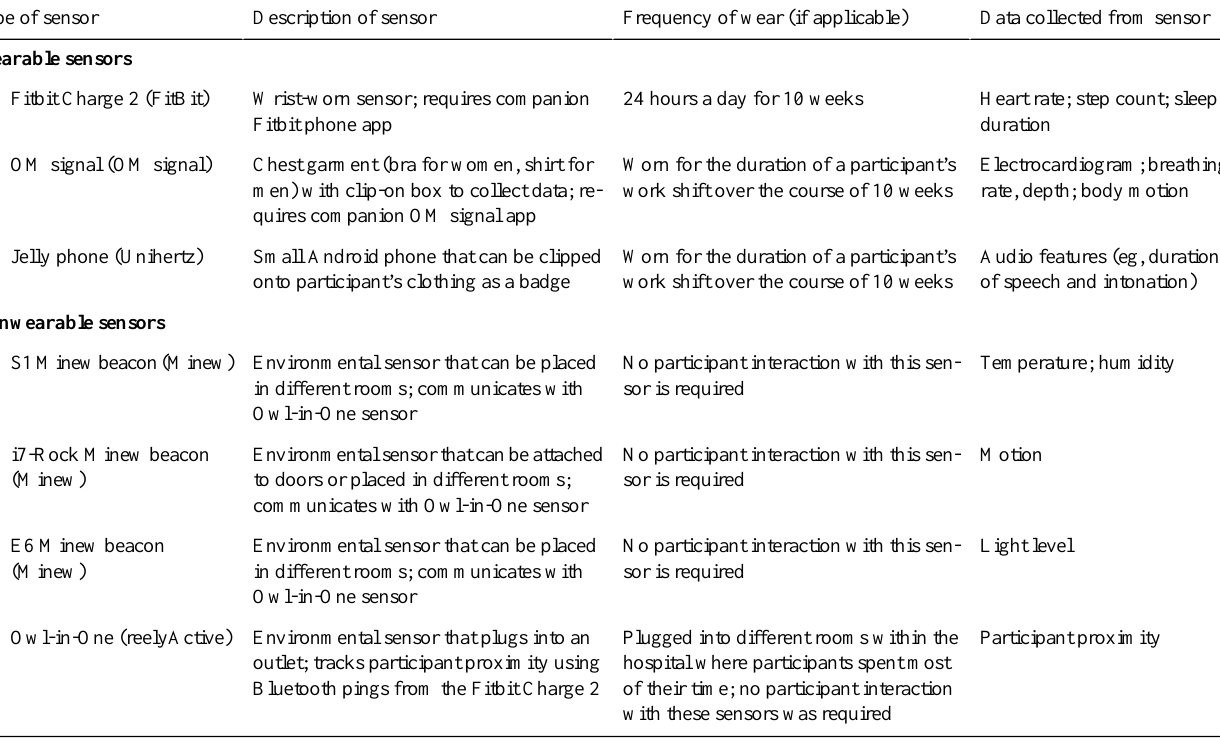
Data collected from sensorFrequency of wear (if applicable)Description of sensorType of sensor